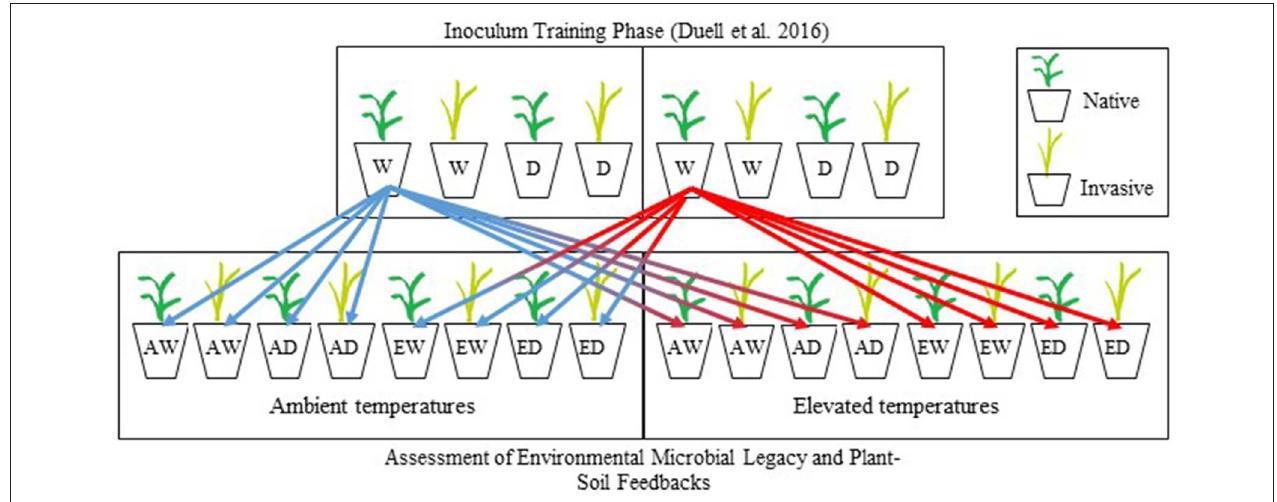
FIGURE 1 | Schematic diagram for the experimental design of the training and experimental testing phases of this research. In the training phase, two warm-season grasses ( Schizachyrium scoparium, Bothriochloa ischaemum ) were grown under four combinations of soil moisture and temperature, replicated 6 times for a complete experimental design of 48 pots. Eight different soil communities conditioned in the training phase were used as inocula in the testing of PSF. The schematic shows only one paired native and invasive grass. As shown by our schematic, each soil treatment from the training phase was divided eight times and used as inoculum for native or invasive plant species of the same functional group, maintained at two soil moistures (well-watered, drought), and 2 temperatures (ambient, elevated). This experimental was replicated using cool-season grasses ( Pascopyrum smithii , Bromus inermis ). W and D, well-watered and drought, respectively; A and E, ambient and elevated temperatures,